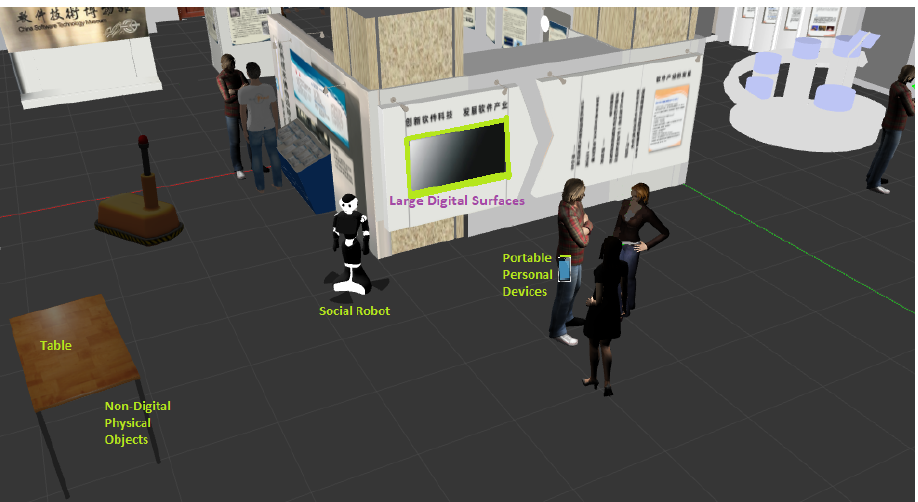
Figure 6. Proxemic interactions associate people to digital devices, digital devices to digital devices, and non-digital physical objects to both people and digital